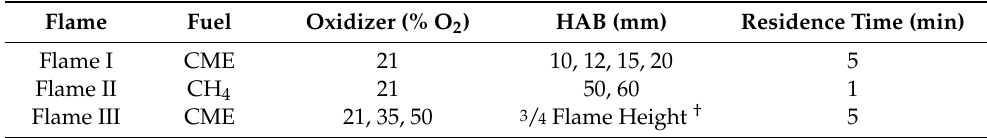
Table 2. Summary of flame parameters for C-layer